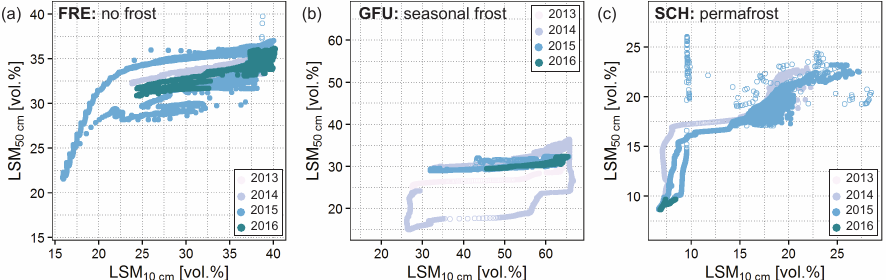
Figure 9. Moisture orbits at FRE (a) , GFU (b) and SCH (c) for the consecutive monitoring years (January 2014–August 2016 at FRE, August 2013–August 2016 at GFU and August 2014–June 2016 at SCH). The hollow circles represent LSM measurements taken when the temperature was below 1 ◦ C at 10cm.